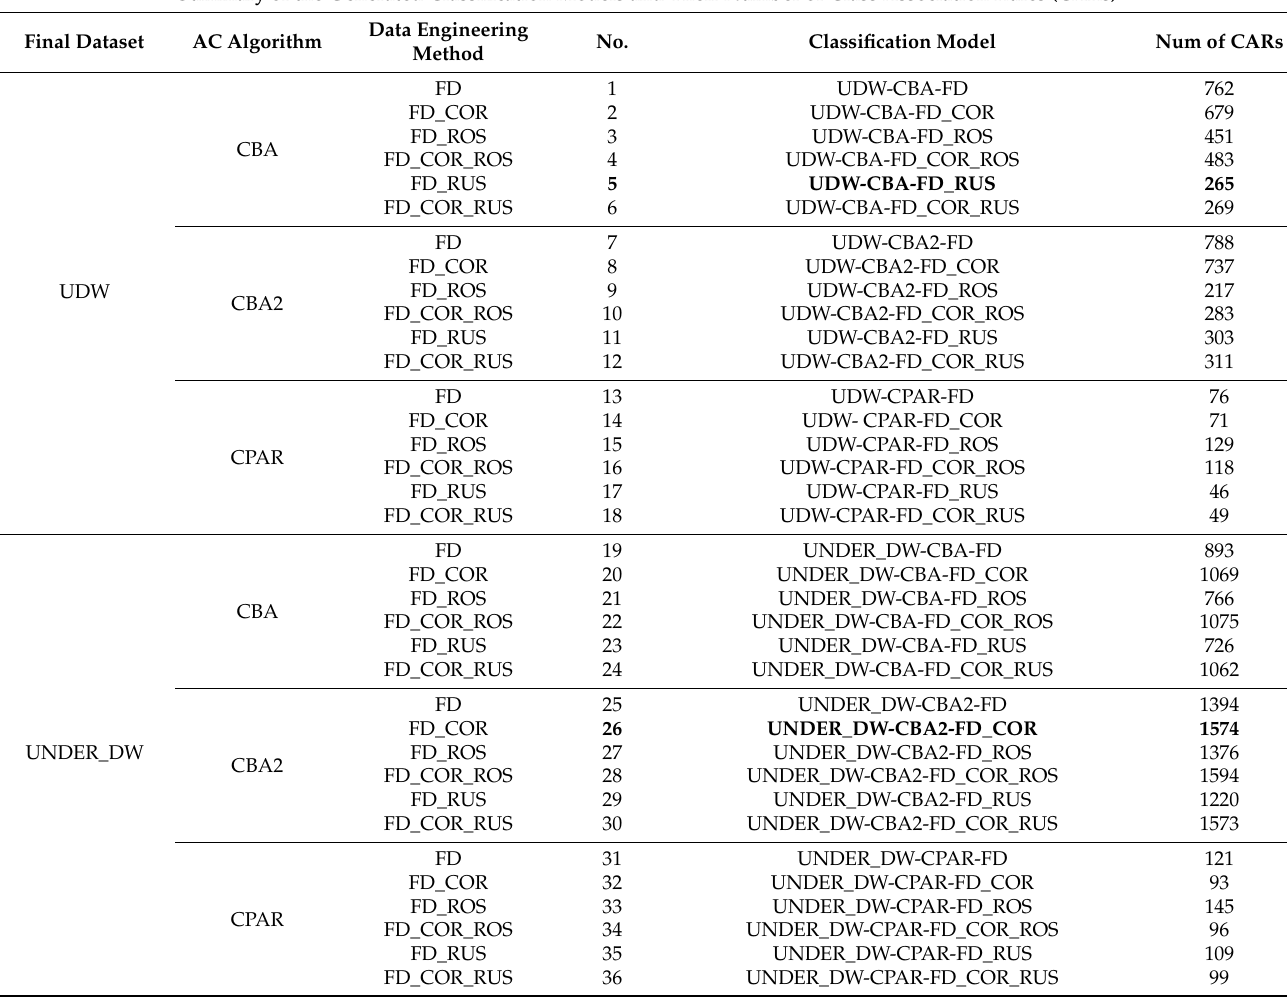
Table 12. Classification models and the corresponding number of